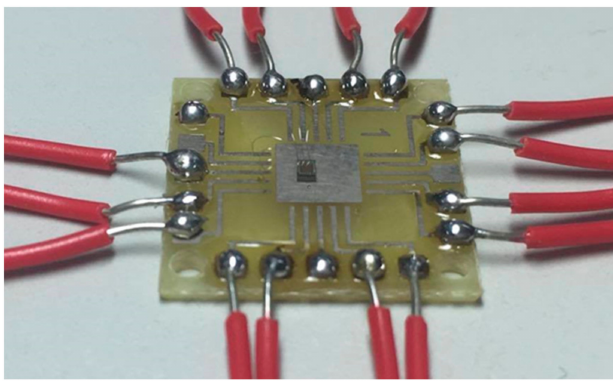
Figure 6. Picture of the MMS after